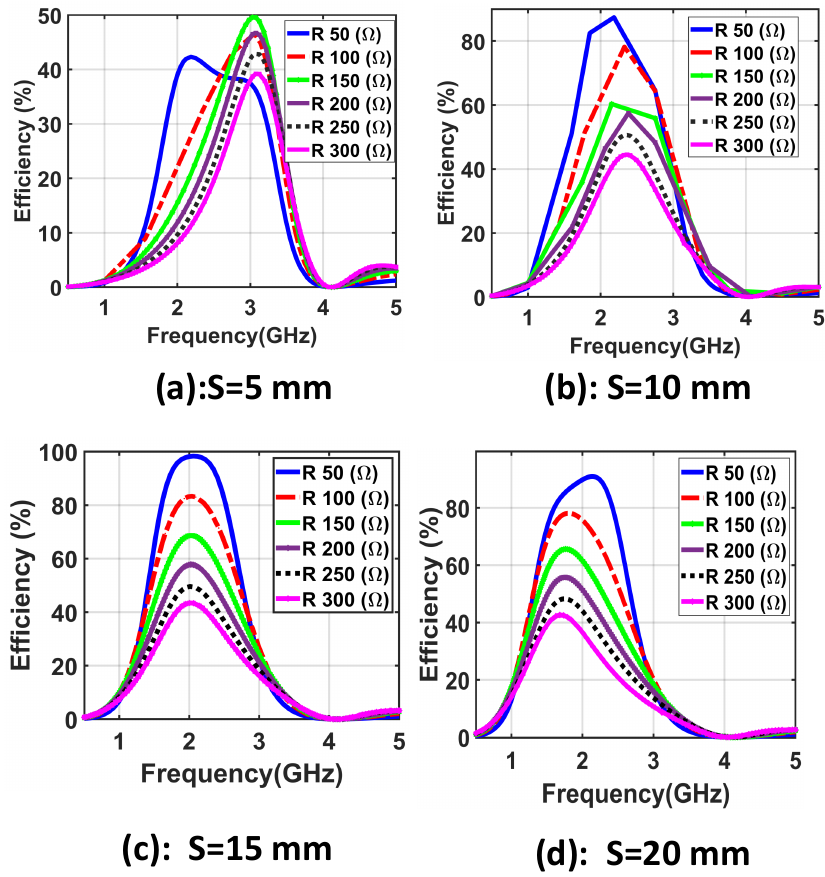
Figure 3. Numerical results showing the efficiency of the proposed antenna with various terminated loads ranging from 50 Ω to 300 Ω , and having a separation distance of ( a ) S = 5 mm, ( b ) S = 10 mm, ( c ) S = 15 mm, and ( d ) S = 20